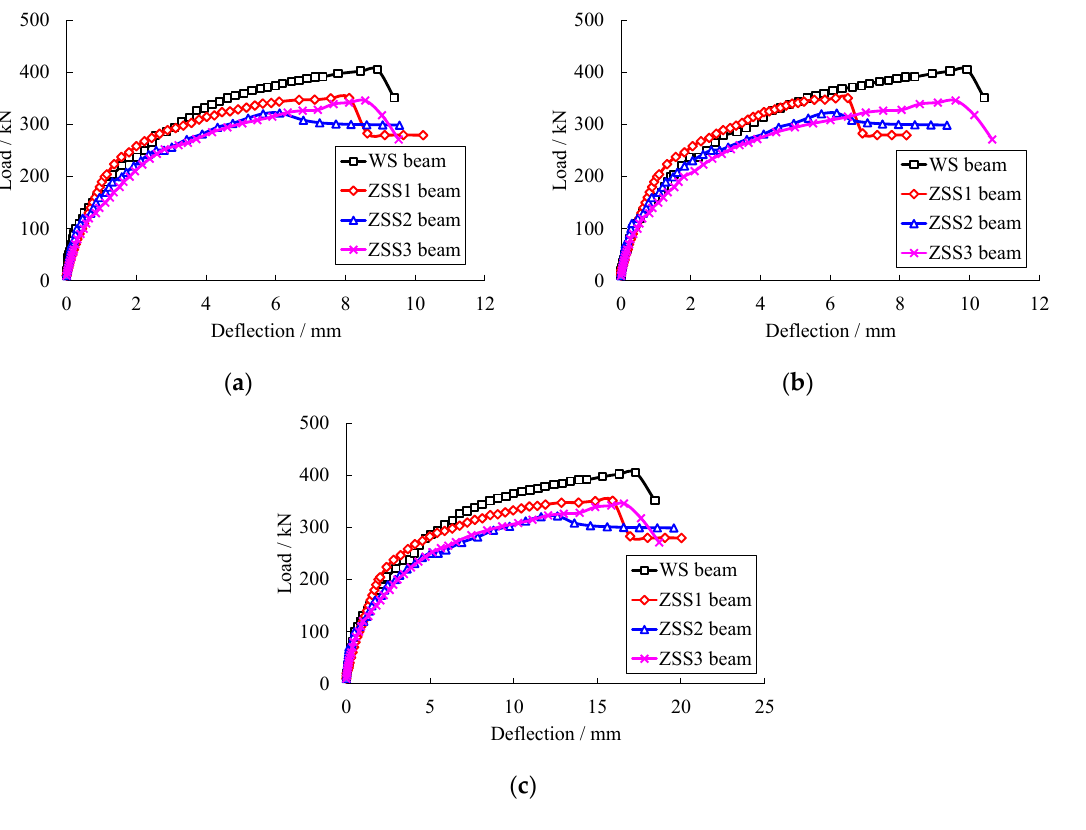
Figure 7. Load-deflection curves for pre-cracking at mid-span. ( a ) l /4 measuring point; ( b ) 3 l /4 measuring point; ( c ) Mid-span measurement point.